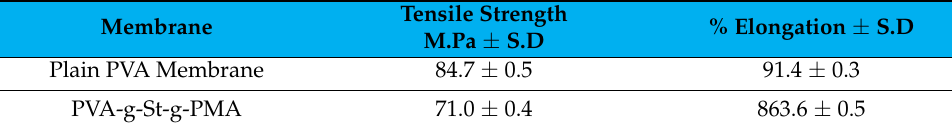
Table 1. Mechanical property of all polymeric